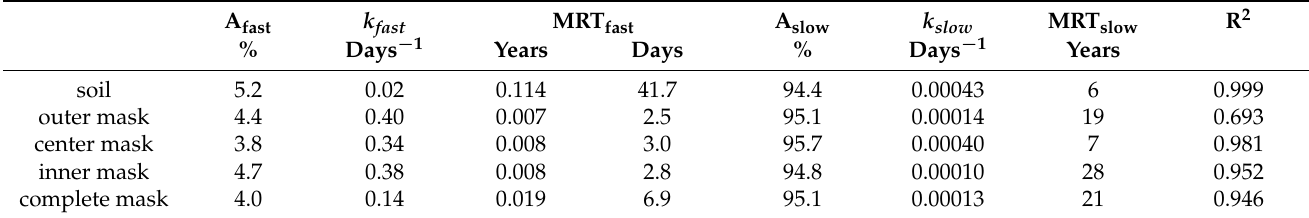
Table 4. Contribution of the fast (A fast ) and slow (A slow ) turning pools of the A horizon of a Cambisol and different layers of single-use face masks amended to this Cambisol, their degradation rate constants ( k fast , k slow ) and the respective mean residence times (MRT fast , MRT slow ). The data derive from a two-component exponential decay model fitted to the mean CO 2 production of four replicates incubated for 6